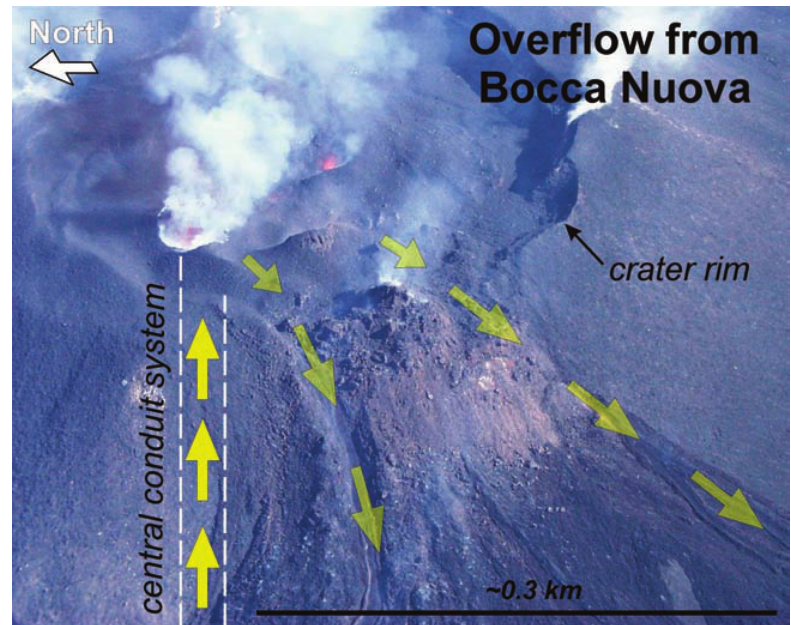
Figure 2. Aerial view of a typical lava overflow from one of the Etna summit craters, the Bocca Nuova, in October 1999. Such overflows are directly fed through the central conduit system, which leads up to the four summit craters of Etna.